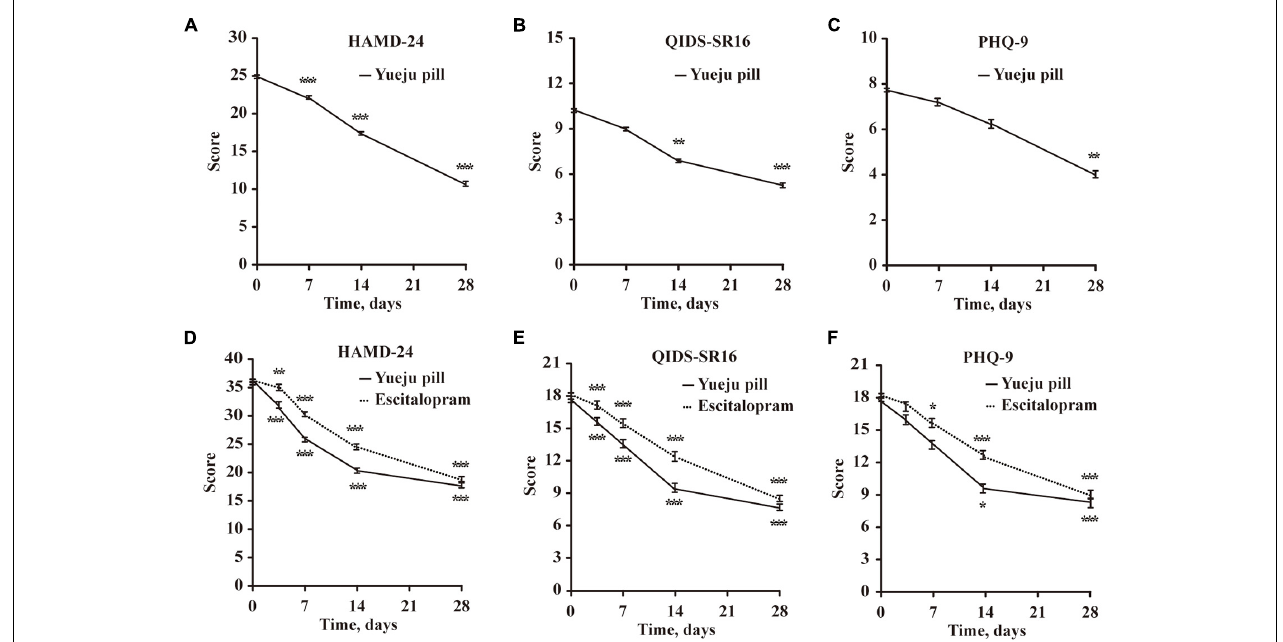
FIGURE 2 | Time course changes of depression scores measured with HAMD-24, QIDS-SR16, and PHQ-9 after treatment in Trial 1 and Trial 2. (A–C) Depression scores Trial 1 in a single-arm trial, with low dose of Yueju Pill treatment for 4 weeks ( n = 15). (D–F) Depression scores in Trial 2 a two-arm randomized controlled trial, with Yueju Pill ( n = 18) or escitalopram treatment ( n = 18) for 4 weeks. Values are expressed as means and standard errors. * p < 0.05, ** p < 0.01, *** p < 0.001, compared with the baseline.